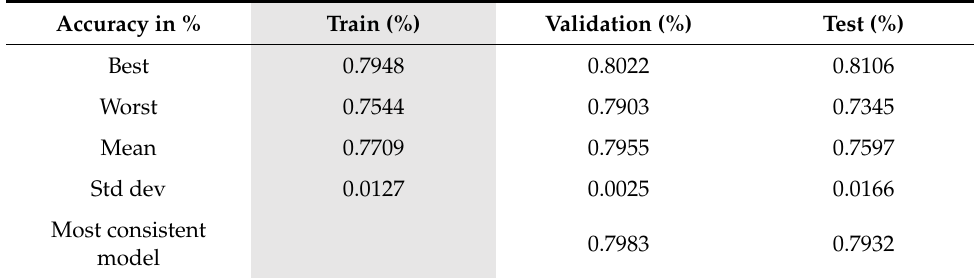
Table 4. Summary table for Approach A4—Random accuracy (in